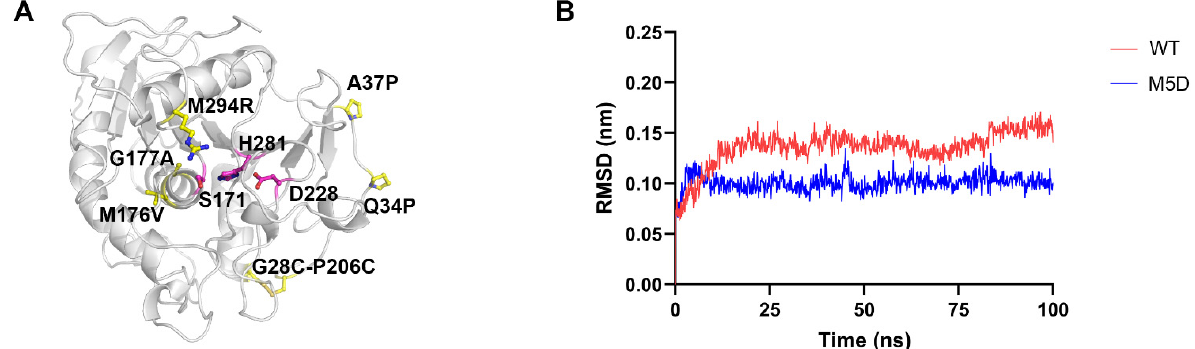
Figure 5. The structure of M5D mutant and MD simulation analysis of the WT and M5D mutants. ( A ) Locations of the mutations of M5D mutant. The structure of mutant M5D was built via mutagen- esis program in YASARA software and the X-ray structure of the WT (PDB ID: 3UUE) was used as the template. The catalytic triad of S171, D228, and H281 is shown as magenta sticks, and mutations are shown as yellow sticks. ( B ) C α RMSD analysis of the WT and M5D mutants at 303 K.